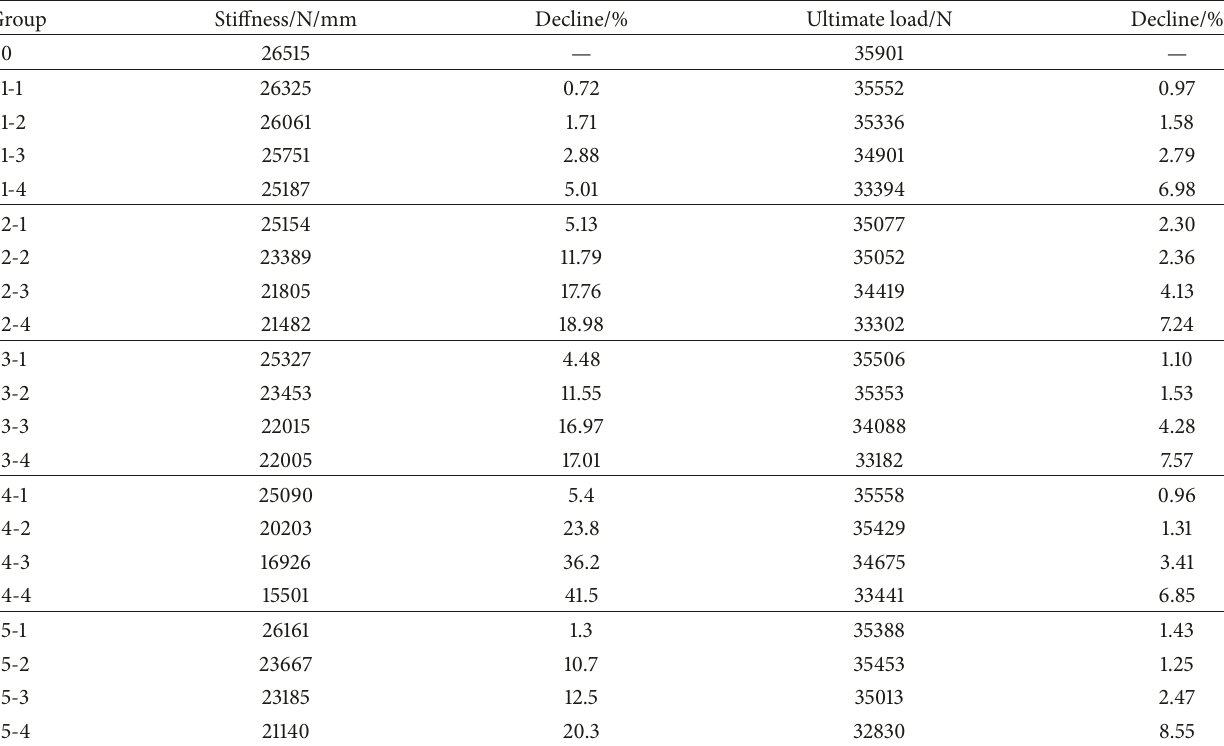
Table 6: The stiffness and ultimate load of FEA results.